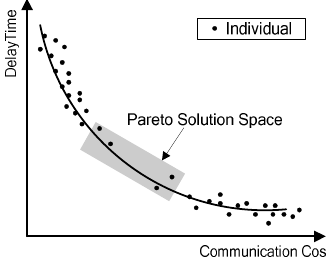
Fig.1. Relationship between Pareto solution and solution space